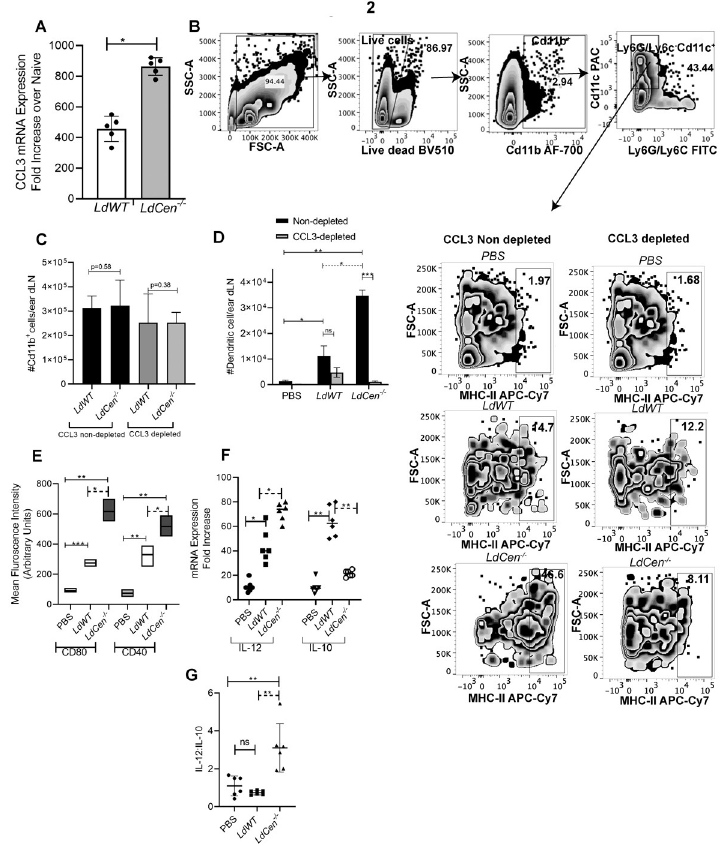
Fig 2. During LdCen -/- ID infection, neutrophil derived increased CCL3 recruits significantly higher number of dendritic cells attributed with proinflammatory phenotype in the ear dLN compared to LdWT infection. (A) Parasitized neutrophils (Cd11b + Ly6G + Ly6c int RFP/mCherry + ) were flow sorted from the ear dLN 5d post infection and mRNA expression levels of CCL3 from sorted neutrophils in the ear dLN were estimated by qPCR as described in Materials and Methods and expressed as fold change from uninfected naive mice. The experiment was repeated three times with pooled digests from five to six ear dLNs per experiment. The data represent the mean values ± SD of results from three independent experiments that all yielded similar results (n = 5). �� p < 0.005 between the groups. (B) The gating strategy and individual flow plots for DCs (CD11b + Ly6G − Ly6C − CD11c + MHCII hi ) recruitment in ear dLNs 5d post infection is shown under CCL3 non-depleted or depleted condition. (C ) Total number of Cd11b + cells recruited in ear dLN 5 days post infection in mice depleted or not of CCL3 has been shown. (D) Changes in the total number of DCs per ear dLN. Values shown are the mean numbers of cells per ear dLN ± SD of results. 6–8 ear dLN, pooled data from 3 independent experiments that all yielded similar results (n = 6). � p < 0.05; �� p < 0.005, ��� p < 0.0005 between the groups. ( E) Parasitized DCs (CD11b + CD11c + MHCII hi RFP/mCherry + ) were flow sorted from the ear dLNs 5d post infection. The Mean fluorescence intensity (MFI) of CD80 and CD40 in flow sorted parasitized DCs from ear dLN were calculated based on flow cytometry results. The data represent the mean values ± SD of results from 3 independent experiments that all yielded similar results (n = 6). � p < 0.05; �� p < 0.005; ��� p < 0.0005 between the groups. (F) Changes in the expression of IL-12 and IL-10 mRNA in sort-selected parasitized DCs were determined by qPCR as described in Materials and Methods (G) and their ratio was determined. The data represent the mean values ± SD of results from three independent experiments that all yielded similar results (n = 6). � p < 0.05; �� p < 0.005; between the